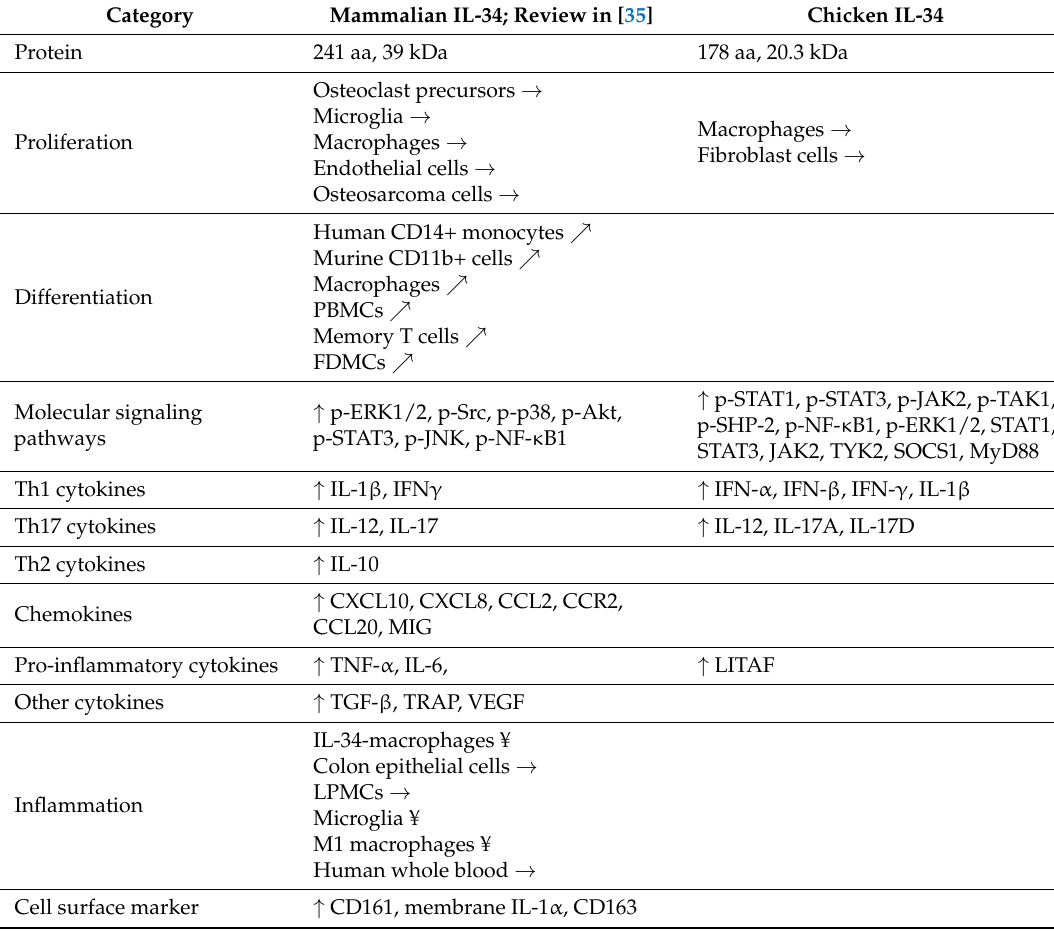
Table 2. Comparison the function of interleukin (IL)-34 in mammals and